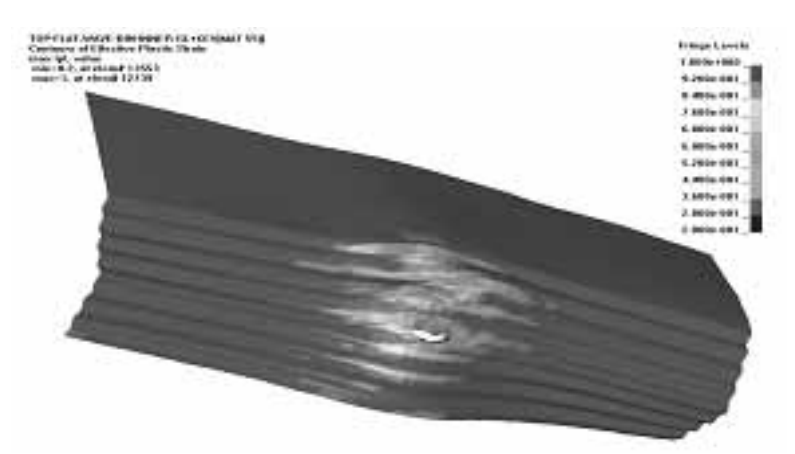
Fig. 30. Outside view of thin shield after test.